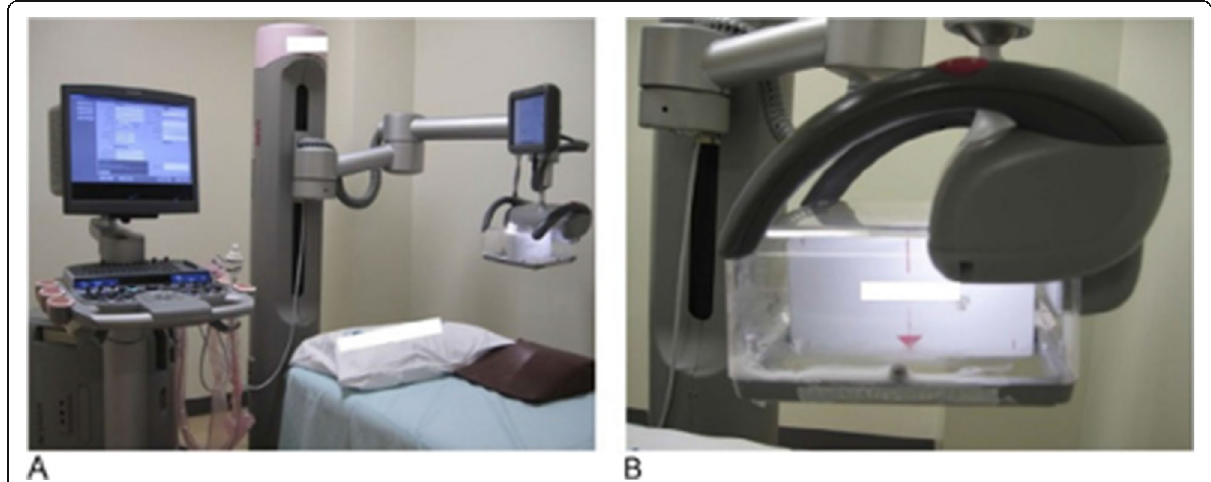
Fig. 7 Automated breast volume scanner. a Acuson S2000 ABVS (Siemens Medical Solutions). The transducer plate ( b ) is positioned over the breast and an automated scan is performed to obtain a series of 2D images. Depending on breast size, more than three scans per breast may